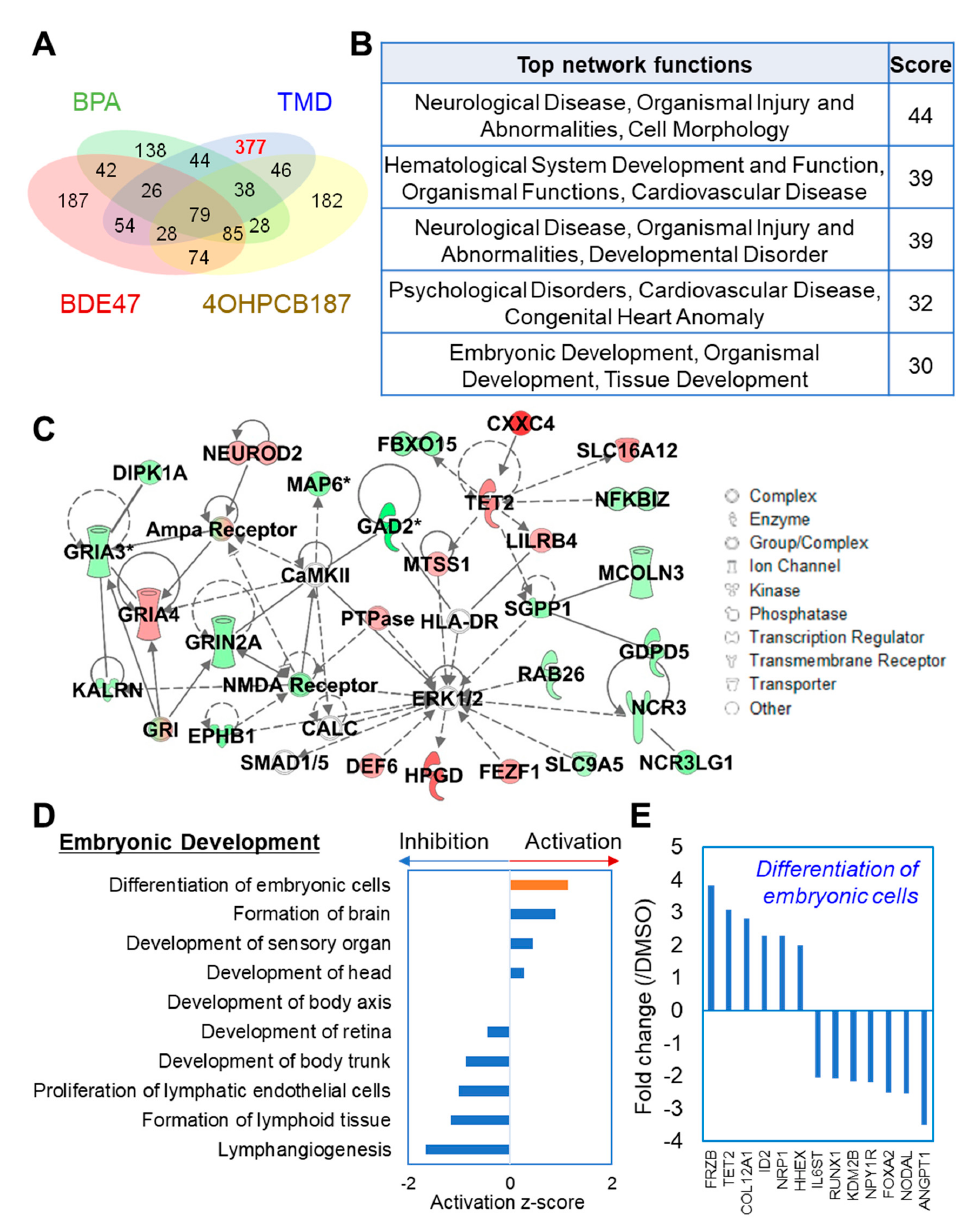
Figure 3. TMD-specific e ff ect on gene expression in hESC-derived spheres. ( A ) Comparison of di ff erentially expressed genes in hESC-derived spheres upon exposure to 1 µ M TMD, 0.01 µ M BDE47, 0.1 µ M BPA, or 0.01 µ M 4OH-PCB187. The red number indicates TMD-specific genes. ( B ) The biological functions of the top populated networks generated in IPA associated with di ff erentially expressed genes specifically induced by TMD exposure. ( C ) A representative network related to